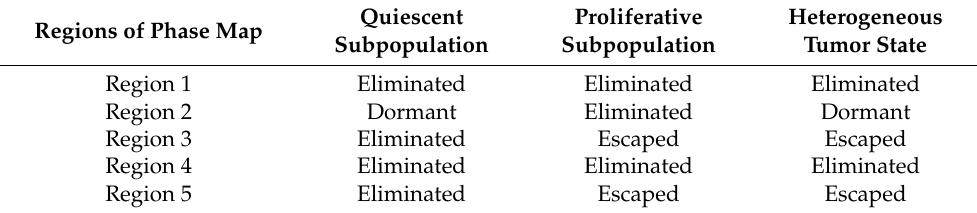
Table 2. The Cellular Fate within the Heterogenous Tumors.